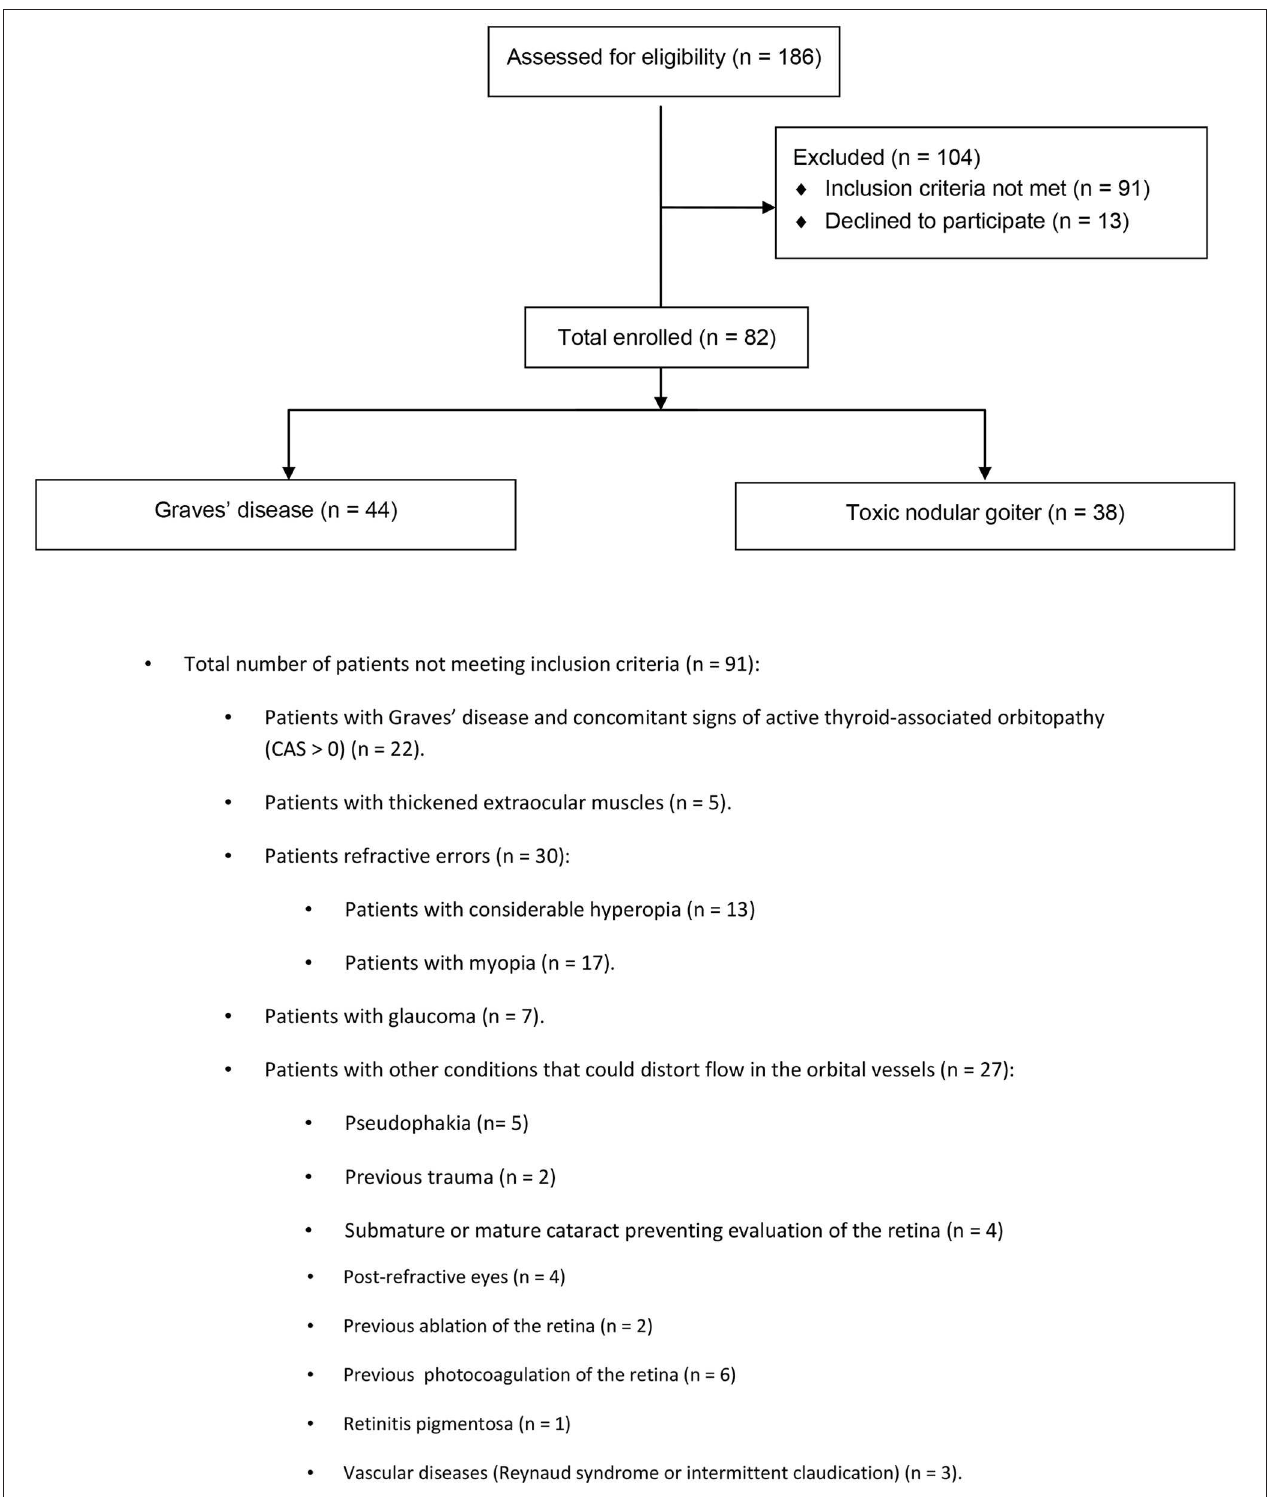
FIGURE 1 | CONSORT study flow chart.